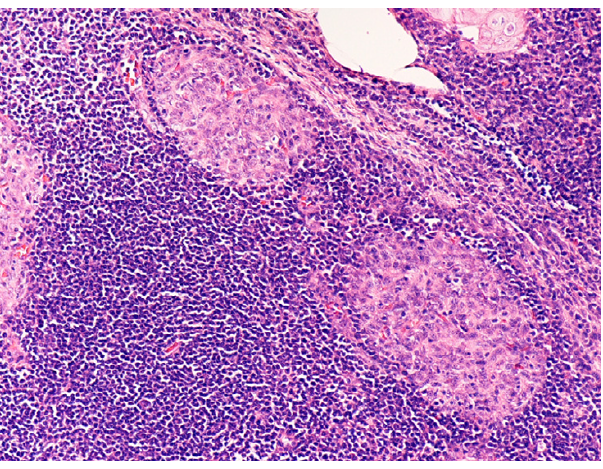
Figure 15 (hematoxylin-eosin, × 100): Micronodular thymoma.